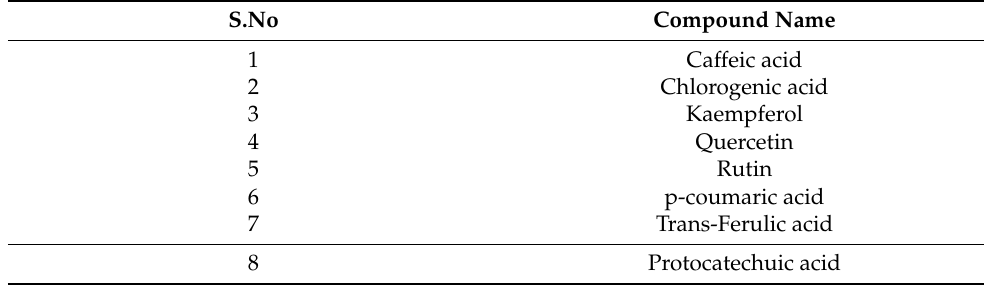
Table 2. List of selected compounds from C. papaya .